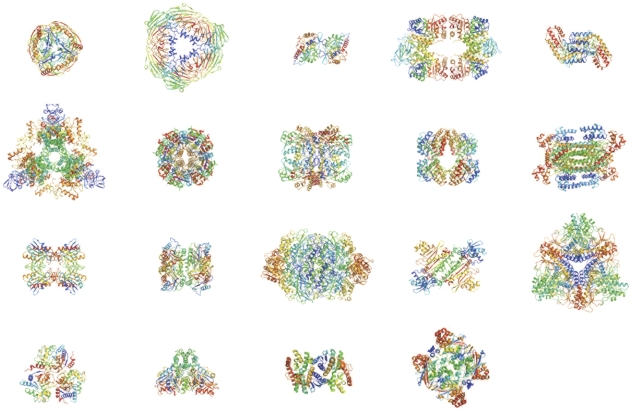
Structures of previously deposited proteins solved during the pipeline.All proteins were oligomers as shown above. Proteins are from top left - inorganic pyrophosphatase (1IPW), 5-keto-4-deoxyuronate isomerase (1XRU), Hsp31 (1N57), pyruvate kinase (1PKY), phosphoserine aminotransferase (1BJN), Citrate synthase (1NXG), ycaC gene product (1YAC), Cystathione gamma-synthase (1CS1), Dihydrodipicolinate synthase (1DHP), Arginosuccinate lyase (1TJ7), Nicotinamide nucleotide transhydrogenase domain I (1×12), MoaB (molybdopterin biosynthesis protein B) (1R2K), Catalase HPII (1GG9), Lysyl-tRNA synthetase (constitutive) (1BBW), Glutamate decarboxylase (1PMO), Glucosamine 6-phosphate deaminase (IHOT), Malate dehydrogenase (2PWZ), Adenylosuccinate synthetase (1CG1), catalase HPII truncated (1YE9).